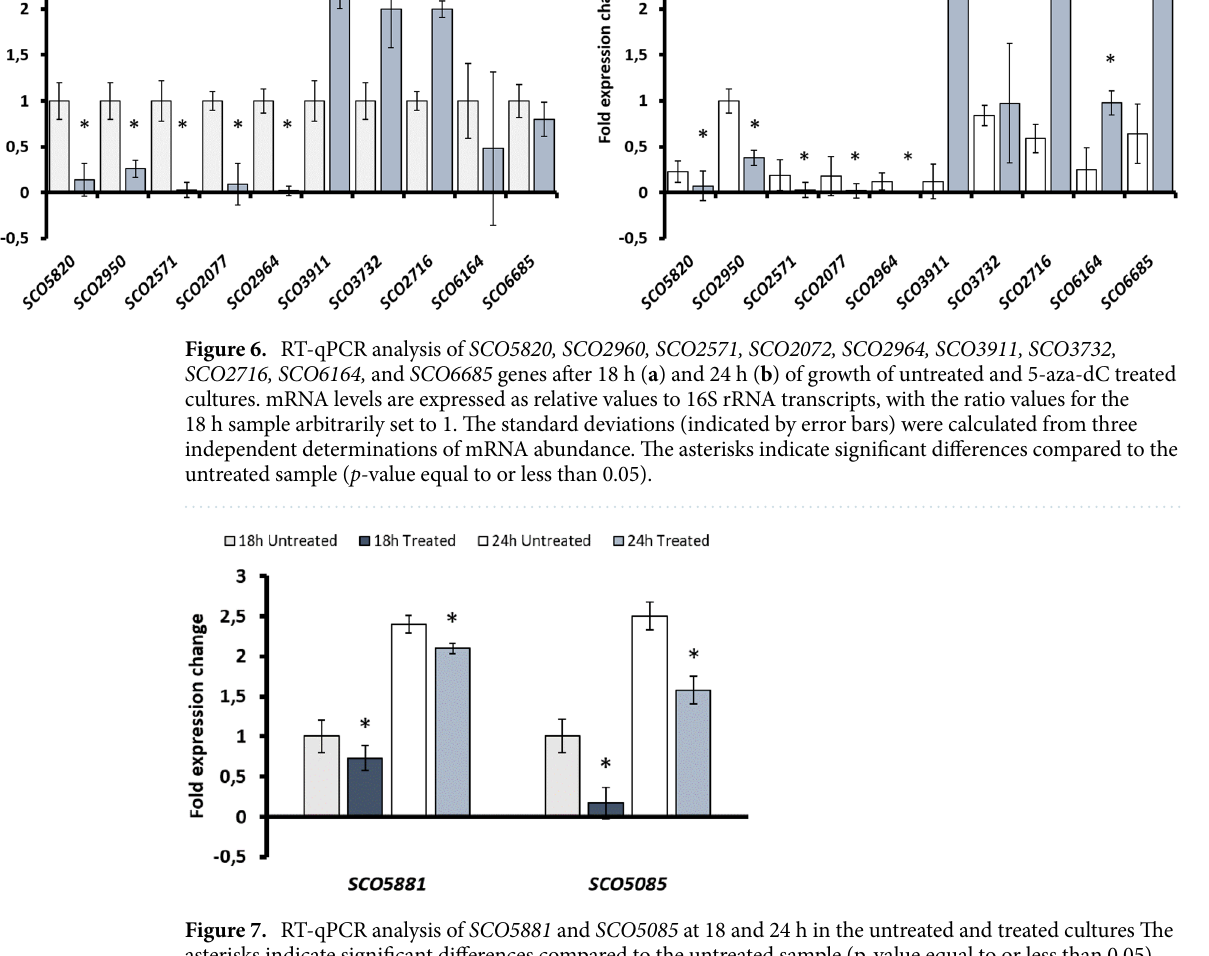
Figure 7. RT-qPCR analysis of SCO5881 and SCO5085 at 18 and 24 h in the untreated and treated cultures The asterisks indicate significant differences compared to the untreated sample (p-value equal to or less than